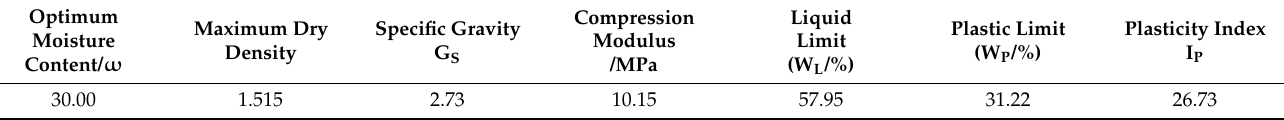
Table 1. Basic physical indexes of red clay in Lingui area of Guilin.